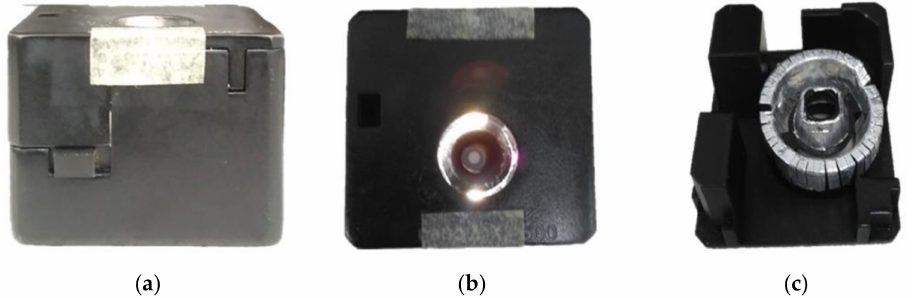
Figure 4. Photos of the finished device housing: ( a ) side view, ( b ) top view, and ( c ) optical path channel.